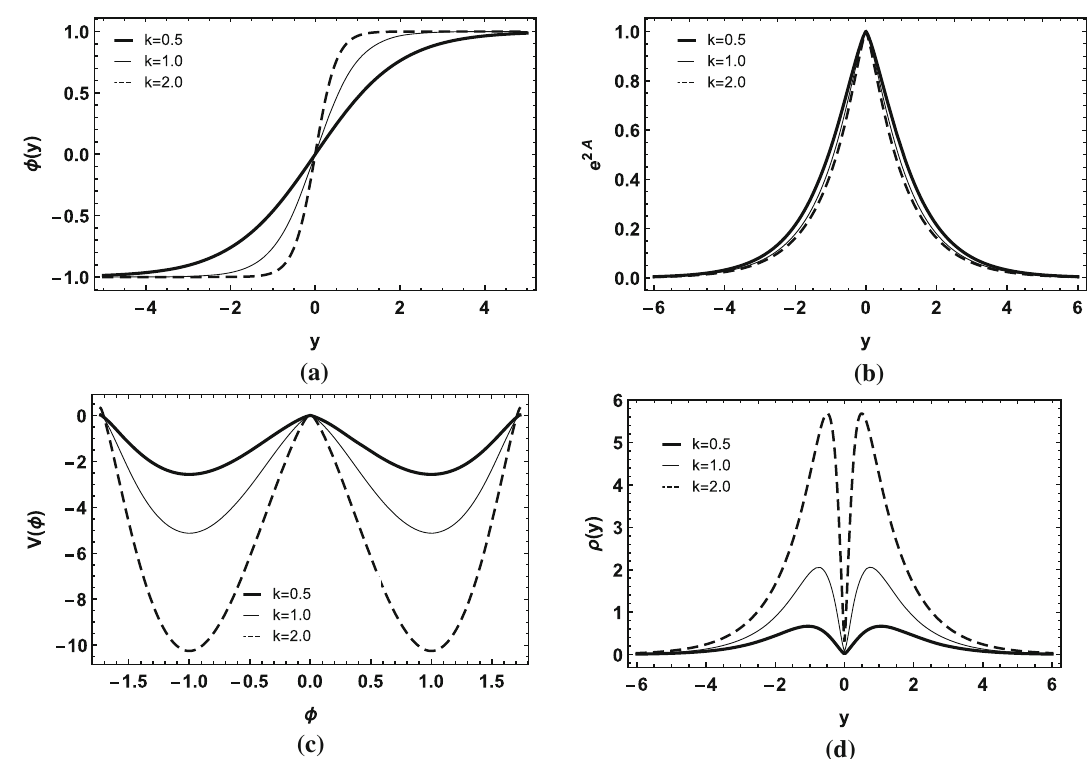
Fig. 4 Plots of the kink solution ( a ), warp factor ( b ), potential ( c ), energy density ( d ), for n = 2 superpotential, where α = β =